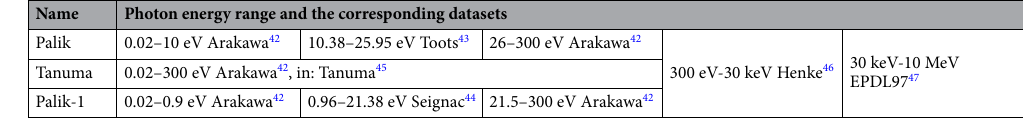
Table. 1. The optical ELF data used for Be.